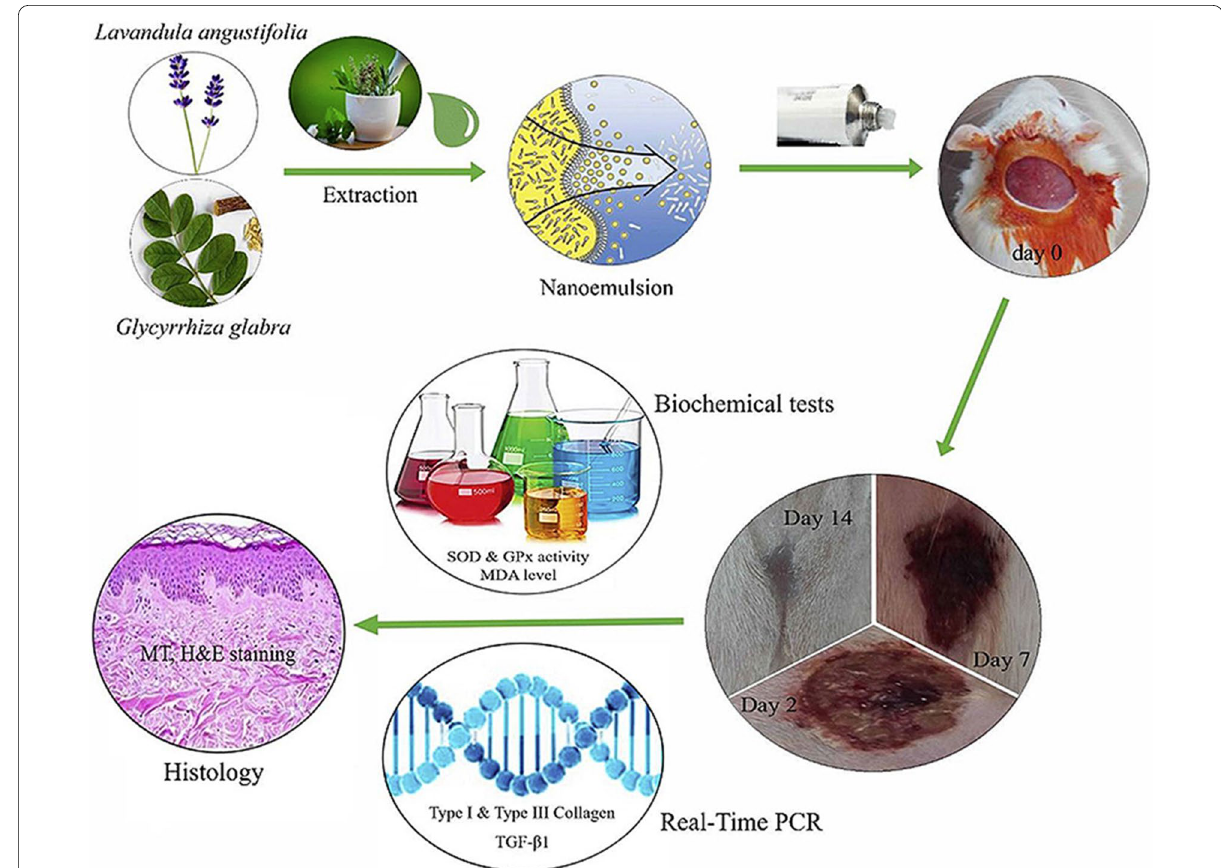
Fig. 4 Lavender nanoemulsion formulation and characterization. Reproduced with permission from Kazemi et al.